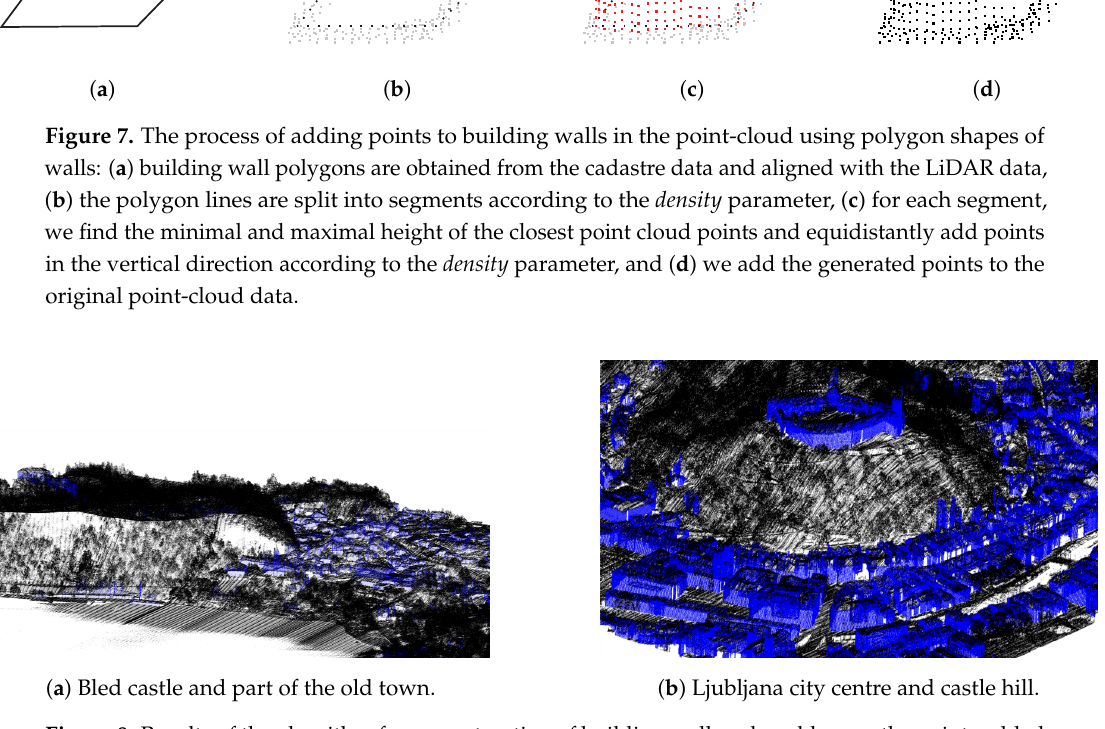
Figure 8. Results of the algorithm for reconstruction of building walls, where blue are the points added by the algorithm and black are the original points from the LiDAR dataset.